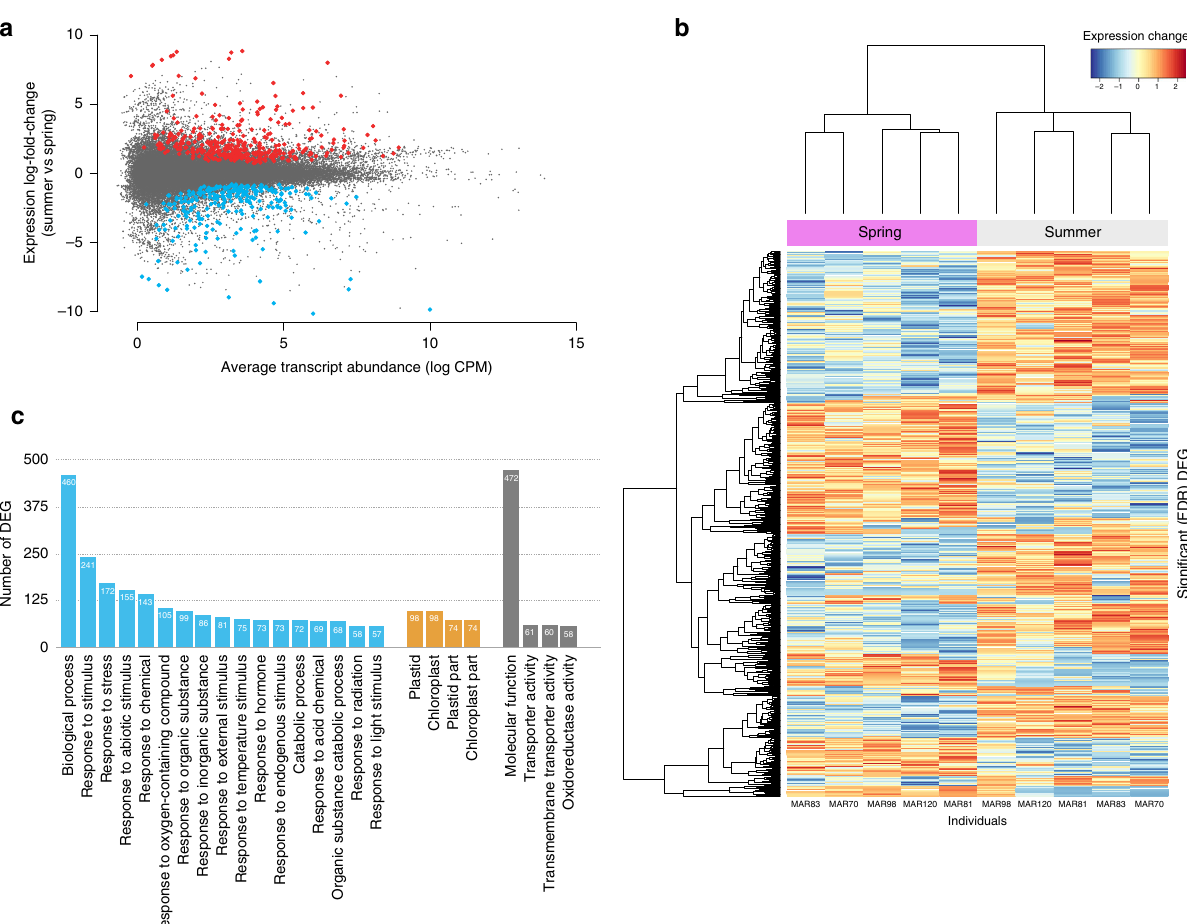
Fig. 4 Between-season differences in fl oral transcriptomes. a MA plot showing the change in expression levels, quanti fi ed as log-fold change ((expression level in summer fl owers − expression level in spring fl owers)/expression level in spring fl owers) in samples from one starting-to-open fl ower bud during experimental spring conditions, and another fl ower bud during experimental mild summer conditions in fi ve plants. Each dot represents a transcript, and log 2 -fold change (summer fl ower/spring fl ower) is plotted against average abundance in log of counts per million (log CPM). Red dots indicate differentially overexpressed transcripts (false discovery rate adjusted P -values < 0.05) in summer fl owers, blue dots indicate differentially under- expressed transcripts in summer fl owers. b Heatmap of hierarchical clustering of the expression matrix of the 627 differentially expressed genes (DEG) in the fi ve individuals in each season. c The fi rst 25 enriched gene ontology (GO) classes after the comparison of GO terms between the DEG and the 47,440 genes that passed the criteria for inclusion in the analyses. GO terms are distributed in three main categories: biological processes (blue bars), cellular components (orange bars), and molecular functions (grey bars). Numbers inside columns indicate the number of DEG in